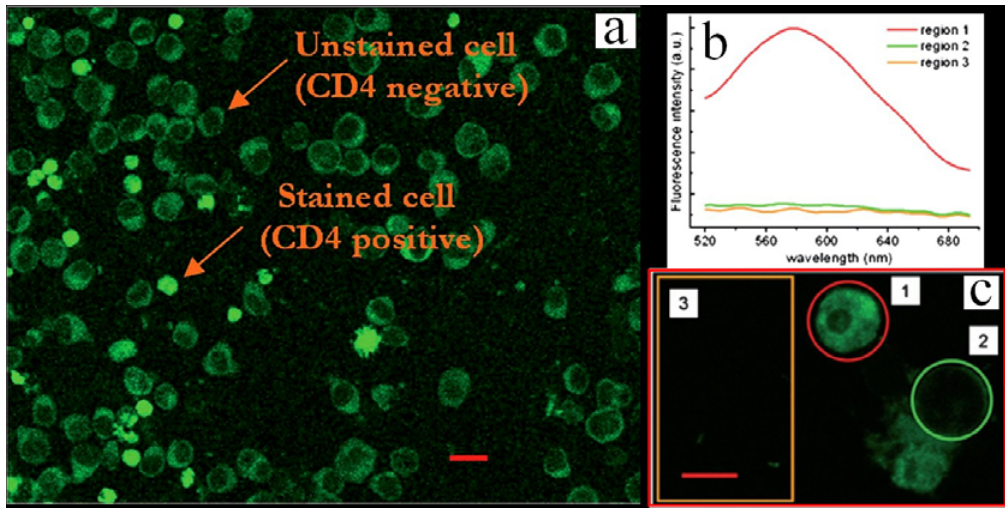
Figure 15. ( a ) Confocal images of Jurkat cells after the release of the anti-CD4 monoclonal antibody labeled with a thiophene fluorophore from PMMA microgels covalently attached on the surface; ( b ) PL spectra of the selected regions 1–3, (enlarged in c ) showing that an intense PL band is only present in the correspondence of the cell (region 1). Scale bars: 20 μ m for a and 10 μ m for c (Reproduced by permission of The Royal Society of Chemistry, from